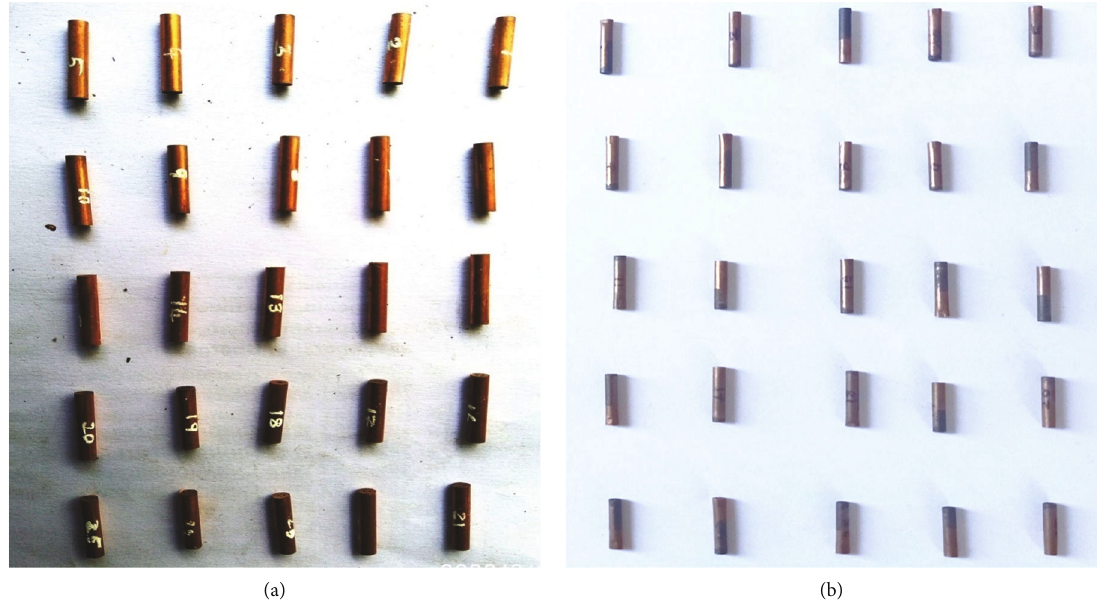
Figure 3: Cylindrical shaped electrodes: (a) before machining; (b) after